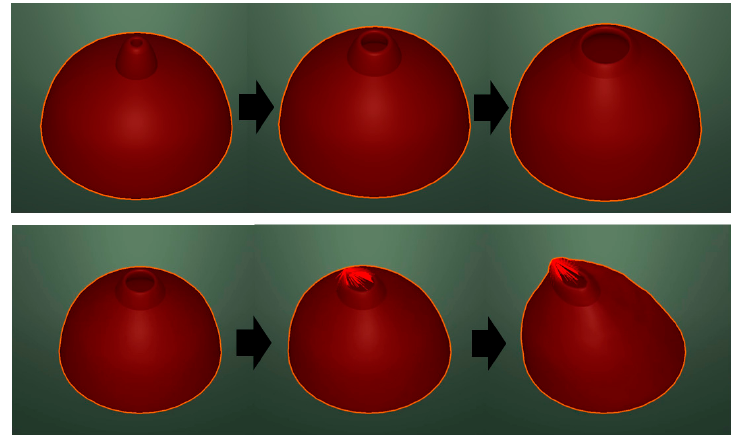
Figure 3. Global deformation—dilation of the cervix ( top ). Local deformation—user manipulation ( bottom ).